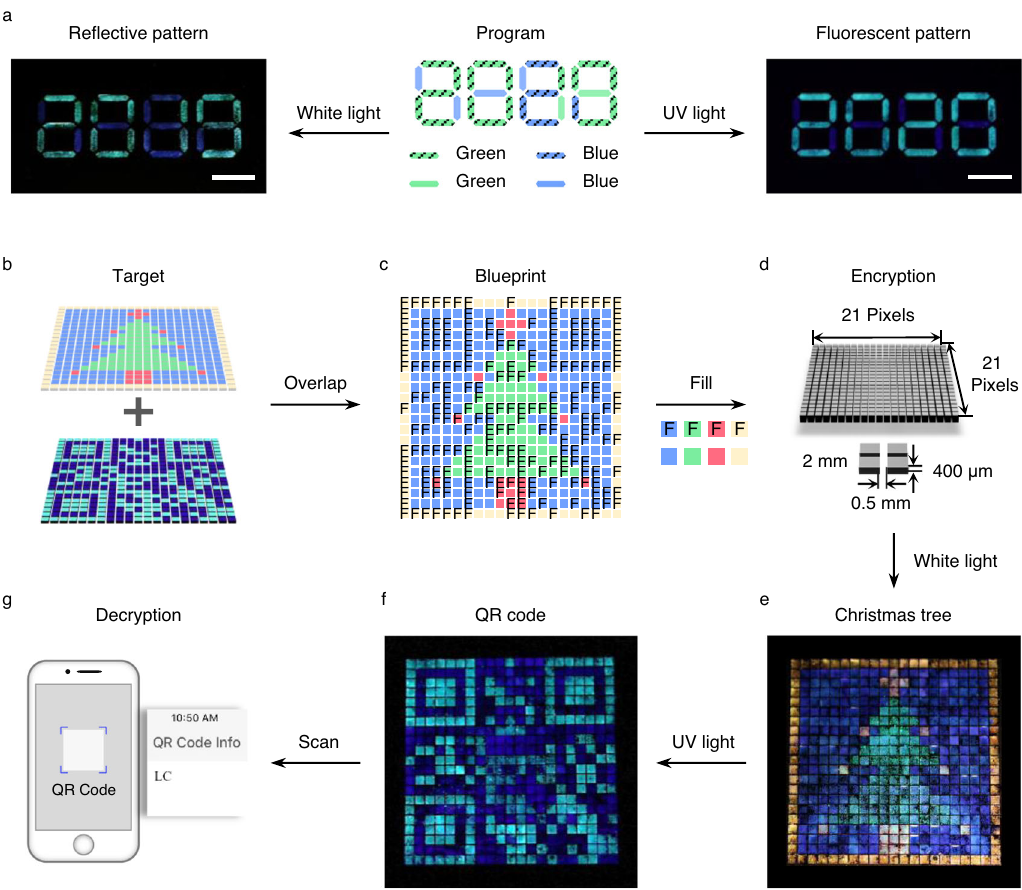
Fig. 4 Geminate labels carrying two distinct kinds of information. a A geminate label with two different messages of a green “ 2019 ” re fl ective pattern and a cyan “ 2020 ” fl uorescent pattern. In program, the color of the rectangles represents the re fl ection colors of the microdroplets and the slashes in the rectangles represent the microdroplets with fl uorescence. The scale bar is 1 cm. b – g Encryption and decryption of an enhanced-security-level geminate label created by eight kinds of microdroplets in a “ pixelated ” array (21 × 21). The fl uorescent QR code of “ LC ” is concealed behind a colorful re fl ective “ Christmas tree ” , which can be decrypted by smartphones upon UV irradiation. Each pixel is 2.0 mm × 2.0 mm × 400 μ m, and the distance between two pixels is 0.5